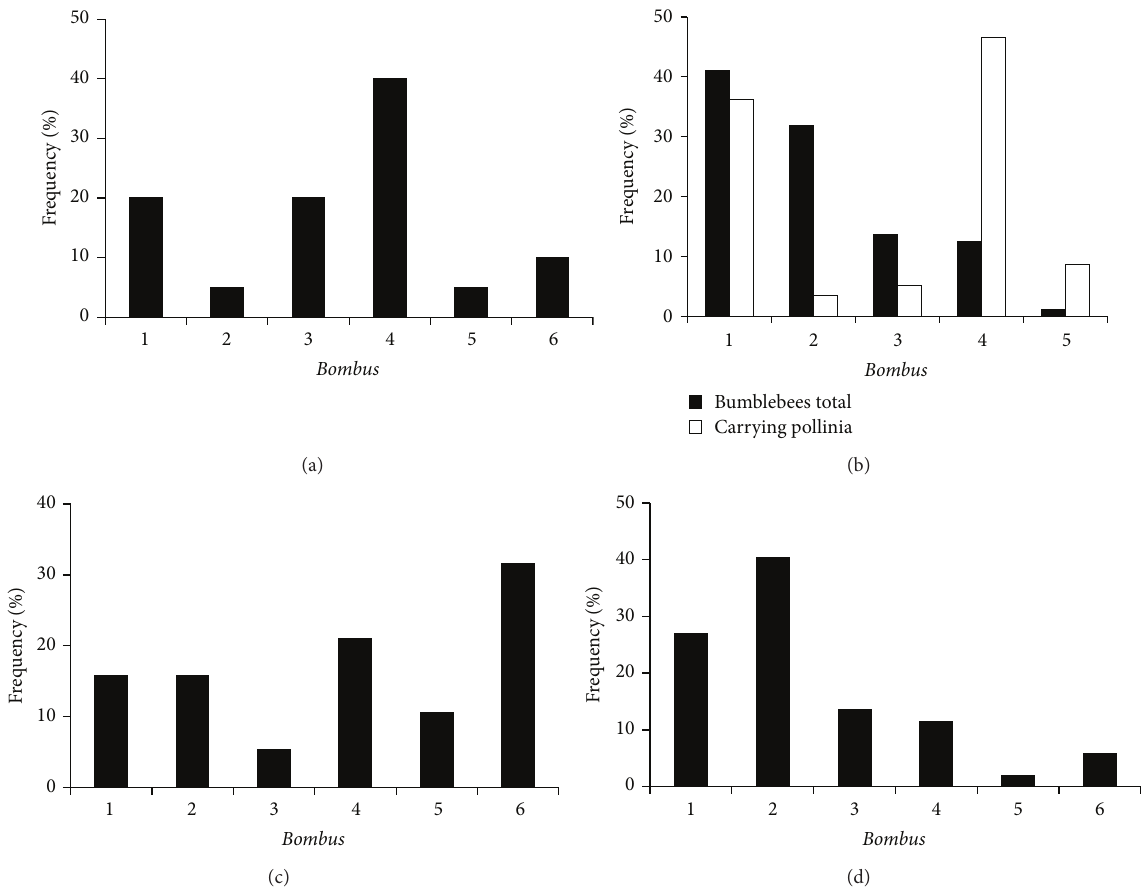
Figure 2: Relative abundance (%) of bumblebee species on (a) Daphne mezereum in 2007–2010, 𝑁 = 20 ; (b) Salix spp. in 2007-2008 including total number of bumblebees (black bars, 𝑁 = 812 ) and individuals carrying Calypso pollinia (white bars, 𝑁 = 58 ), (c) Calypso bulbosa in 2007–2010, 𝑁 = 19 , and (d) Vaccinium myrtillus in 2007, 𝑁 = 58 . Species: 1 = Bombus hypnorum/cingulatus , 2 = B. jonellus , 3 = B. lucorum , 4 = B. pratorum , 5 = B. pascuorum , and 6 = Bombus